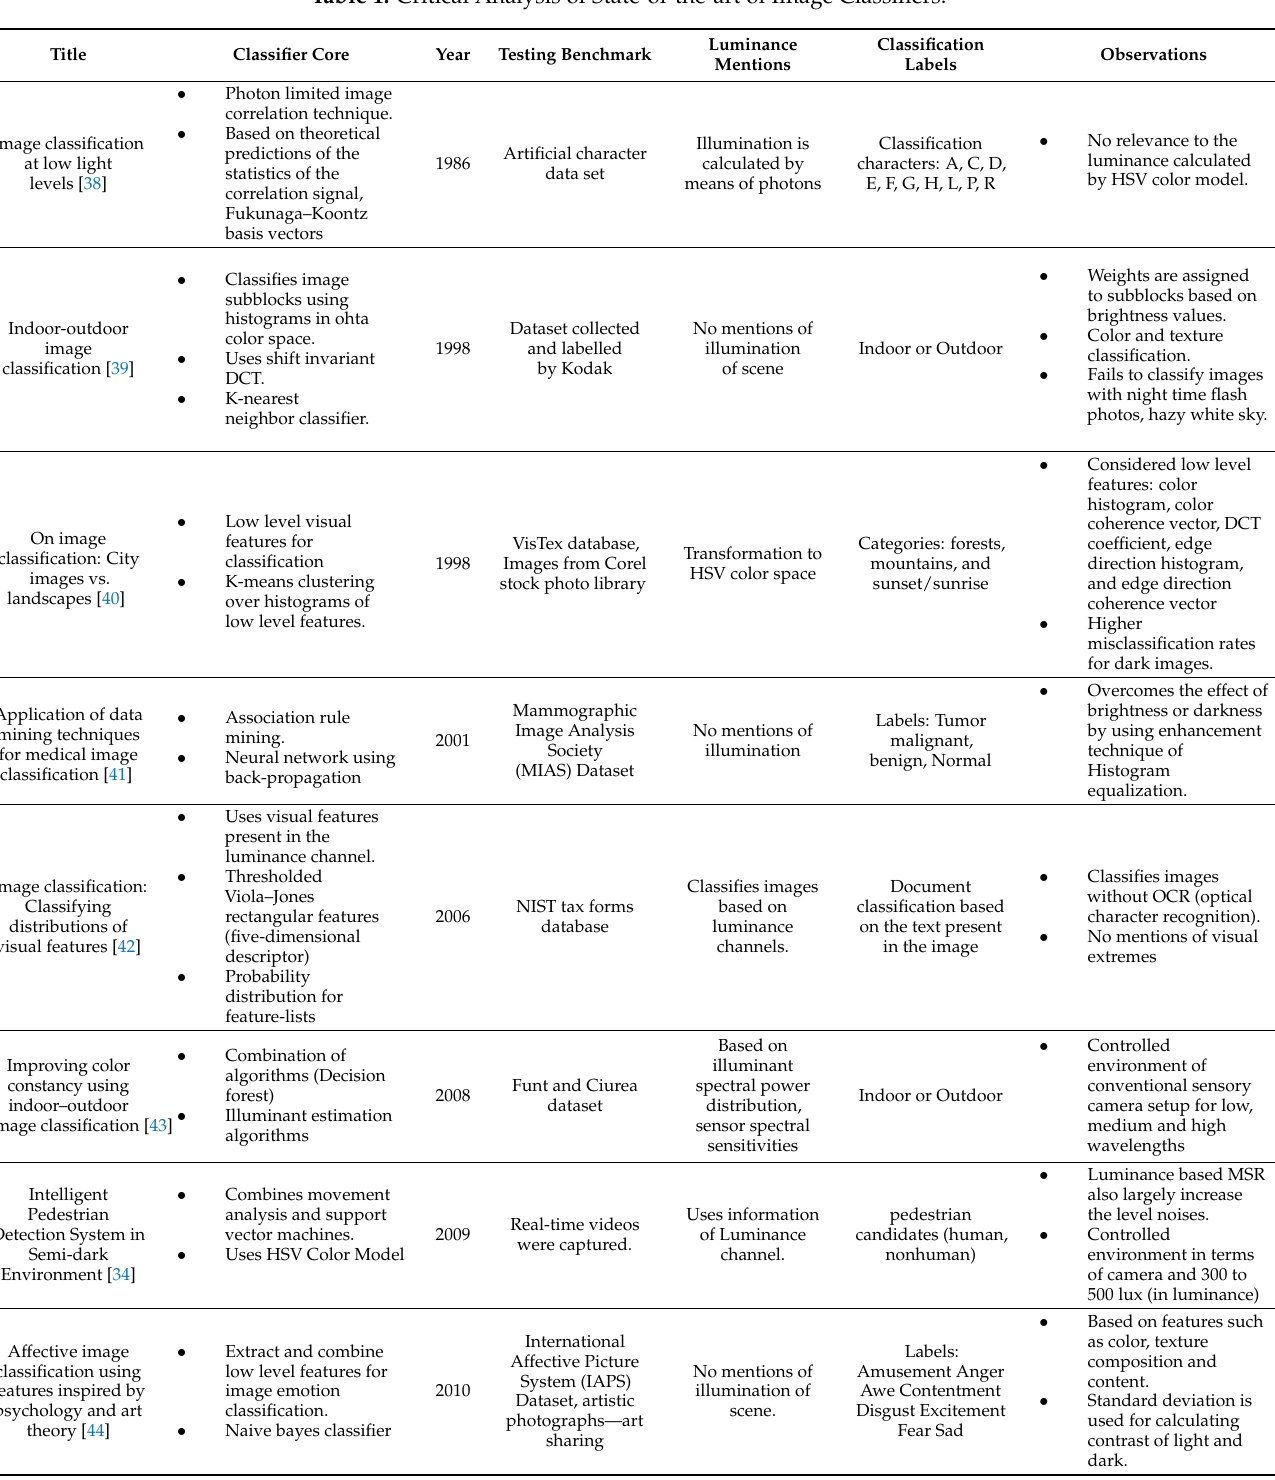
Table 1. Critical Analysis of State-of-the-art of Image